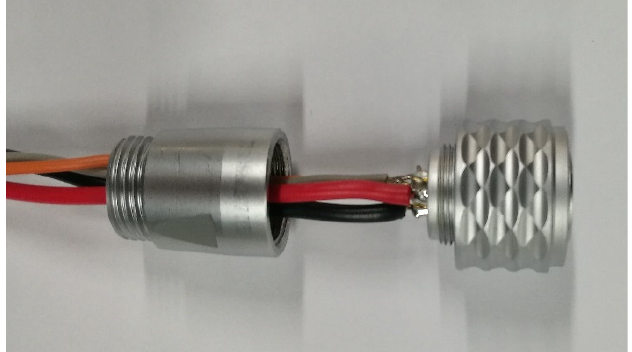
Figure 26. Pin circuit welding of aviation plug.